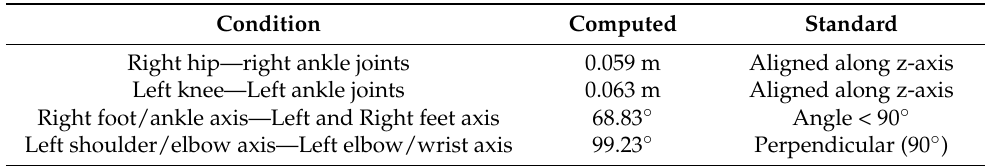
standards for the Shuto Uke on Neko Aishi Dachi. Condition Computed Standard Right hip—right ankle joints 0.059 m Aligned along z-axis Left knee—Left ankle joints 0.063 m Aligned along z-axis Right foot/ankle axis—Left and Right feet axis 68.83 ◦ 99.23 ◦ Perpendicular (90 ◦